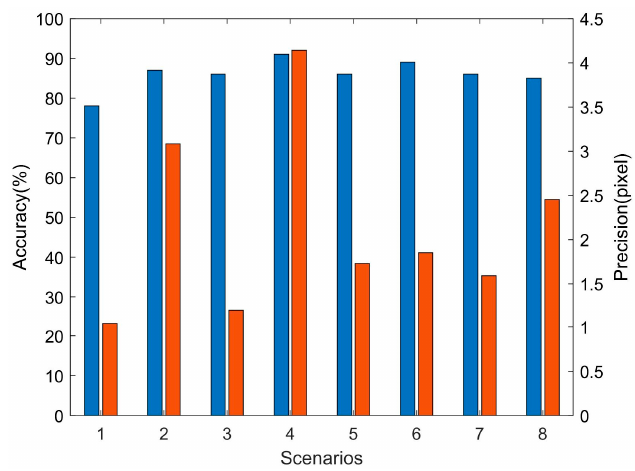
Figure 9. Algorithm performance in 8 scenarios.